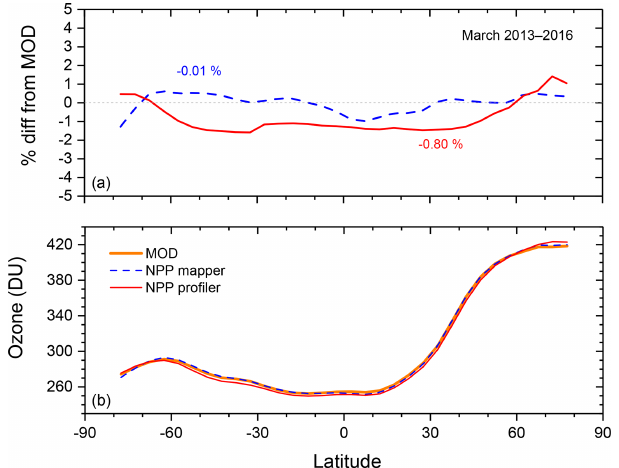
Figure 7. An average of ozone sonde data from Hilo, Hawaii, is compared with OMPS NP version 2 ozone profiles for coincident days, with percent difference plotted in (b) . The NP profile inte- grates to 274.1DU, while the sonde profile integrates to 272.5DU when a climatological stratospheric amount is added.